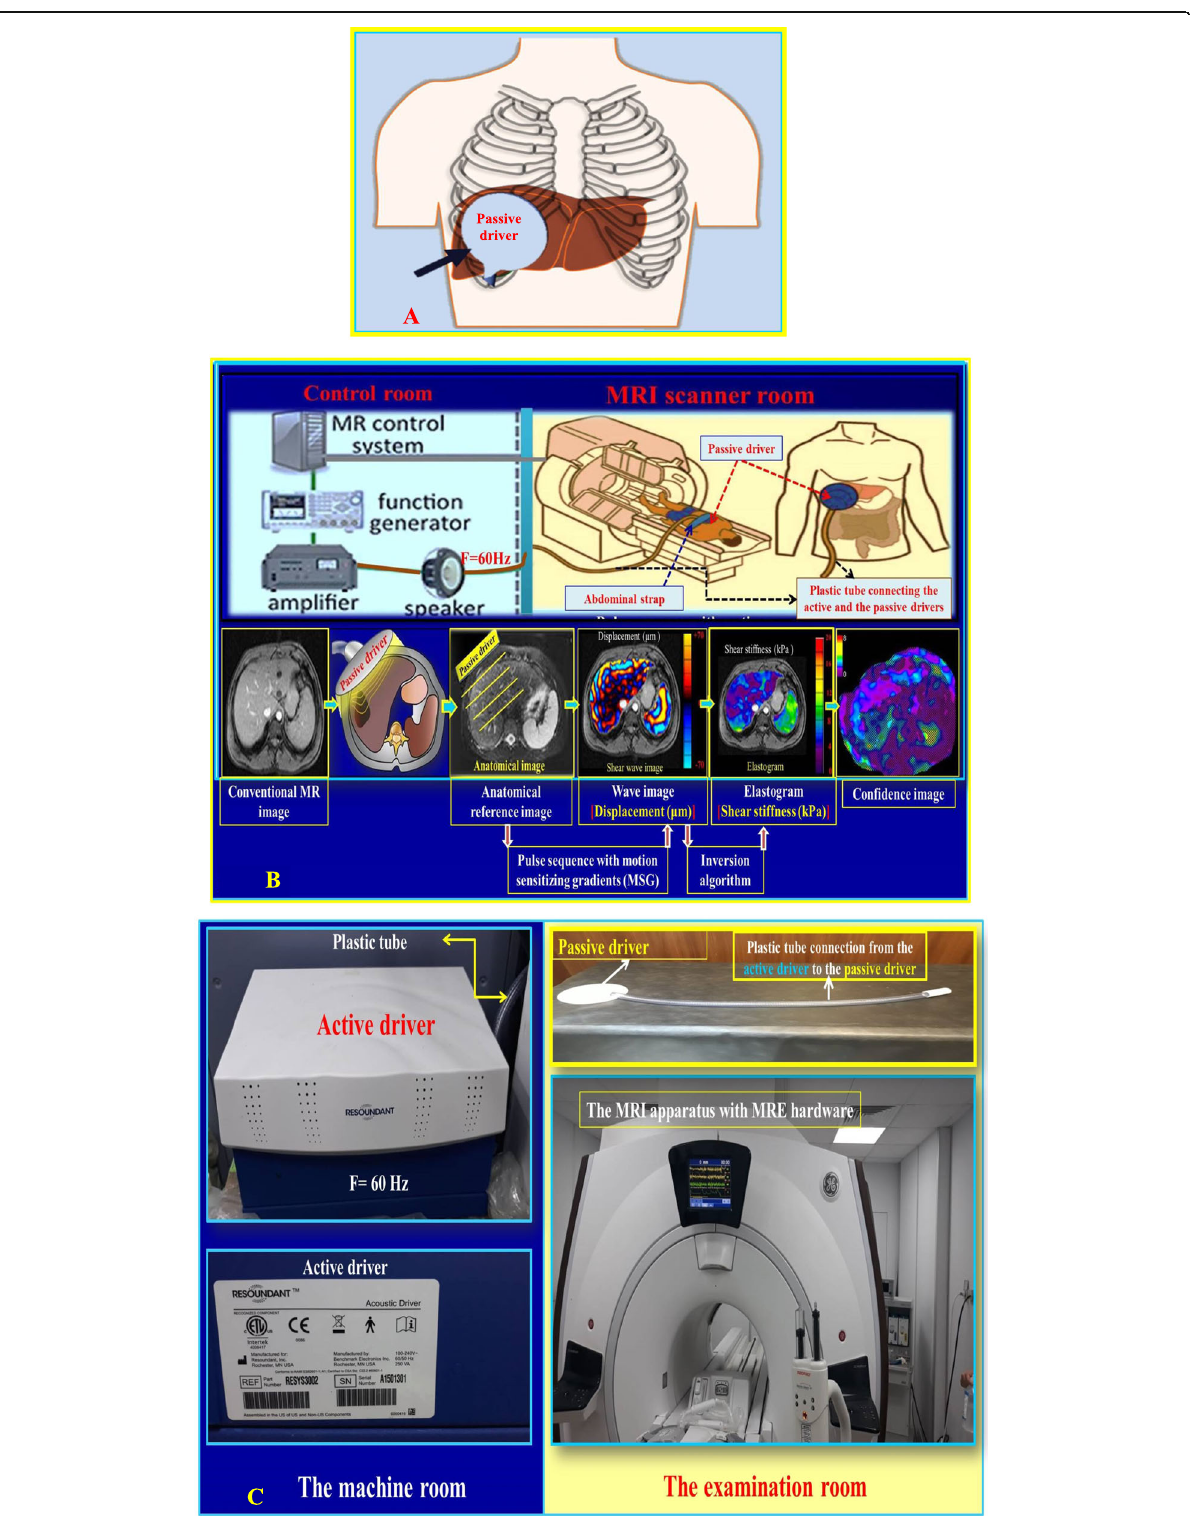
Fig. 1 a – c Demonstrates illustrative images, which highlight the area of placing the MRE passive driver on the donor ’ s liver at the level of xiphisternum ( a ), as well as components and generated images of MRE technique ( b ), (Quoted from Stoopen-Romettia et al. [10], Venkatesh et